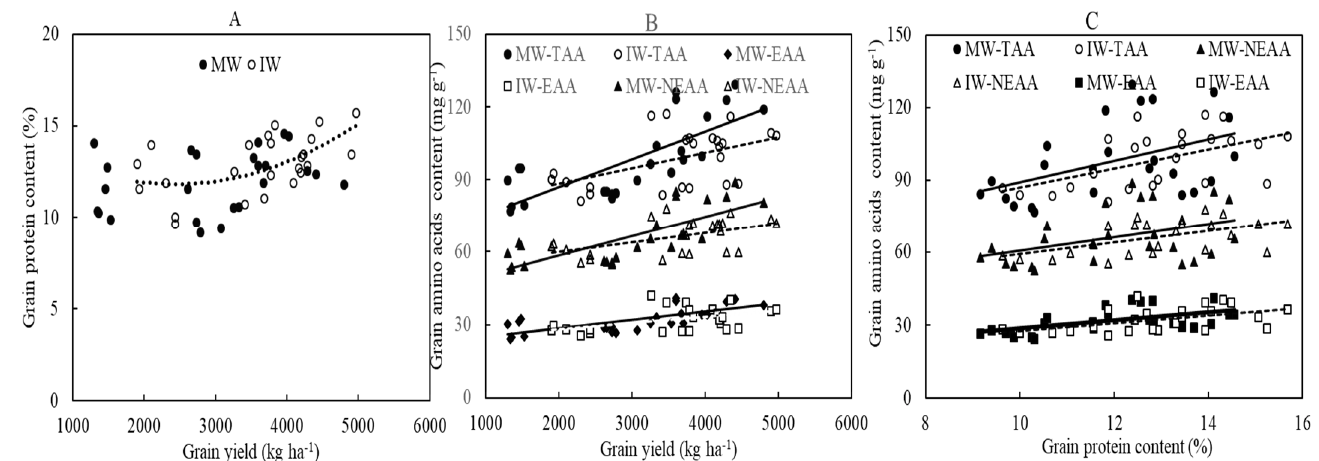
Figure 5. Relationship analysis among grain yield, grain protein content, and grain amino acids fraction. ( A ) Relationship between grain yields and grain protein content. In panel A, grain yield as a function of grain protein content for IW (y = 5E − 07x 2 − 0.0025x + 14.833, R² = 0.3228, p = 0.017, n = 24); ( B ) relationship between grain yields and grain amino acids fraction. In panel B, grain yield as a function of MW − TAA (y = 0.0115x + 63.997, R² = 0.5679, p = 0.00, n = 24), IW − TAA (y = 0.0065x + 75.28, R² = 0.2636, p = 0.01, n = 24), MW − NEAA (y = 0.0081x + 42.344, R² = 0.5676, p =0.000, n = 24), IW − NEAA (y = 0.004x + 51.937, R² = 0.2774, p = 0.008, n = 24), MW − EAA (y = 0.0034x + 21.653, R² = 0.5219, p = 0.00, n = 24), and IW − EAA (y = 0.0025x + 23.343, R² = 0.2135, p = 0.023, n = 24). ( C ) Relationship between grain protein content and grain amino acids fraction. In panel C, grain yield as a function of MW − TAA (y = 4.435x + 44.956, R² = 0.2079, p = 0.025, n = 24), IW − TAA (y = 3.9529x + 47.562, R² = 0.2924, p = 0.006, n = 24), MW − NEAA(y = 2.7833x + 32.919, R² = 0.1662, p = 0.048, n = 24), IW − NEAA (y = 2.4028x + 35.344, R² = 0.2968, p = 0.006, n = 24), MW − EAA (y = 1.6517x + 12.038, R² = 0.2976, p = 0.006, n = 24), and IW − EAA (y = 1.5501x + 12.218, R² = 0.2506, p = 0.013, n = 24). MW, mono − cropped wheat; IW, intercropping wheat. TAA, NEAA, and EAA: total amino acids, non − essential amino acids, and essential amino acids, respectively. The dot − dashed line and solid line represent linear regressions for IW and MW, respectively.